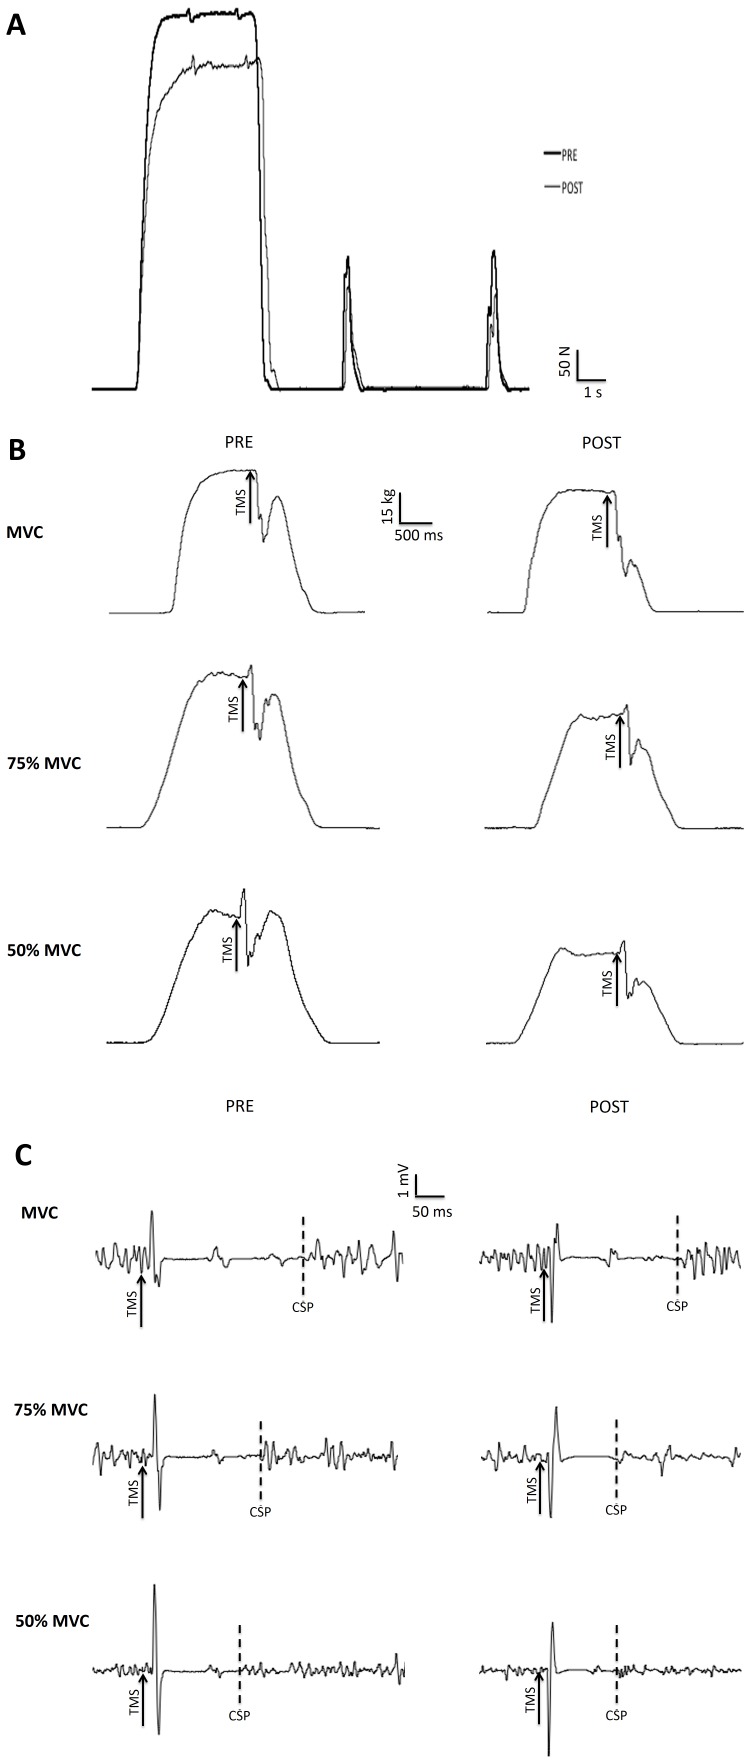
Typical traces recorded before (Pre) and after (Post) the 4-h cycling bout of exercise for MVC force and potentiated doublets (panel A), maximal voluntary activation assessed with TMS during contractions at 100%, 75% and 50% MVC (panel B), and motor evoked potential for the rectus femoris muscle recorded during contractions at 100%, 75% and 50% of MVC (panel C).Arrows indicates the time of transcranial magnetic stimulation (TMS). Dotted lines indicate the end of the cortical silent period (CSP).